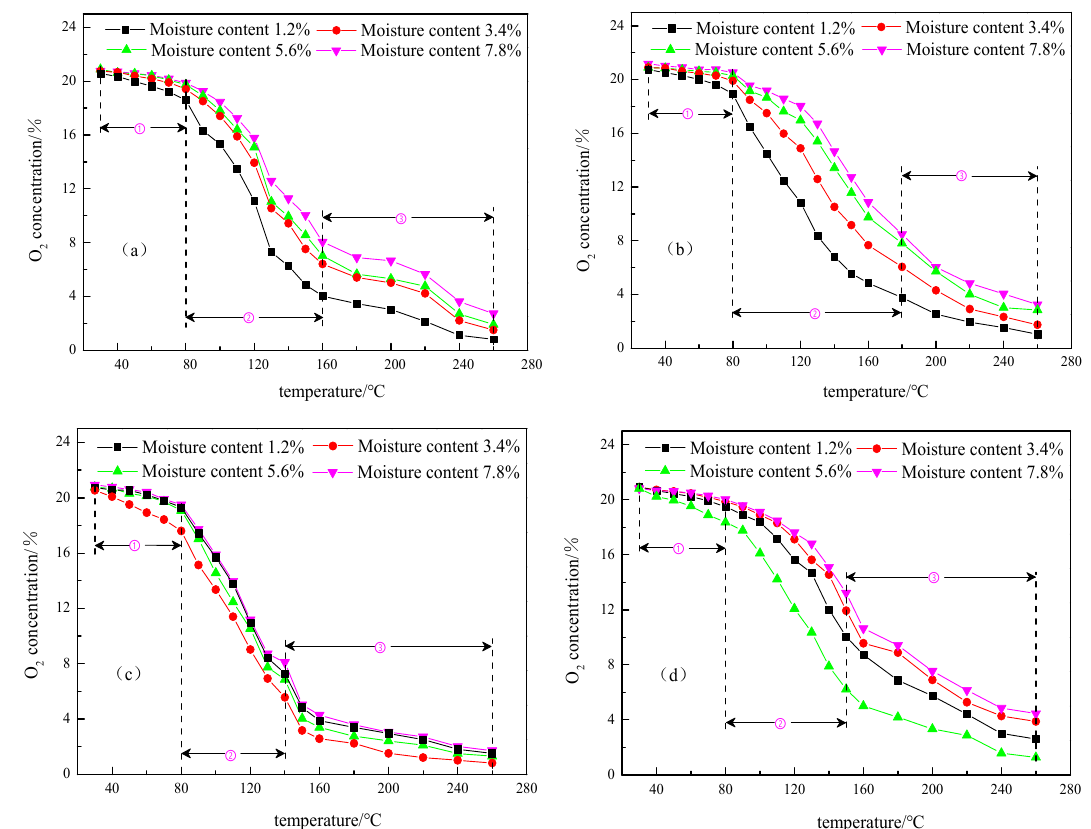
Figure 4. The curves of O 2 concentration consumption for anthracite ( a ), fat coal ( b ), long flame coal ( c ), lignite ( d ) at four different low moisture contents. ① indicates the slow oxidation stage, ② indicates the rapid oxidation stage, and ③ indicates the violent oxidation stage.